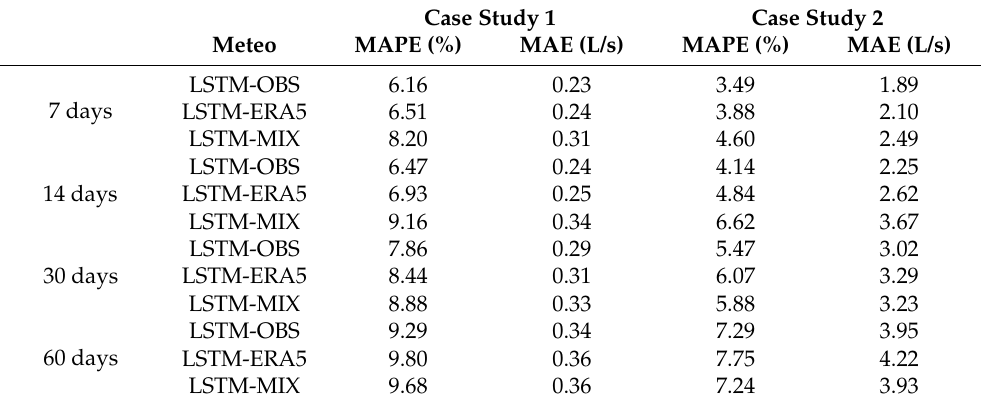
Table 4. Evaluation metrics of case studies.